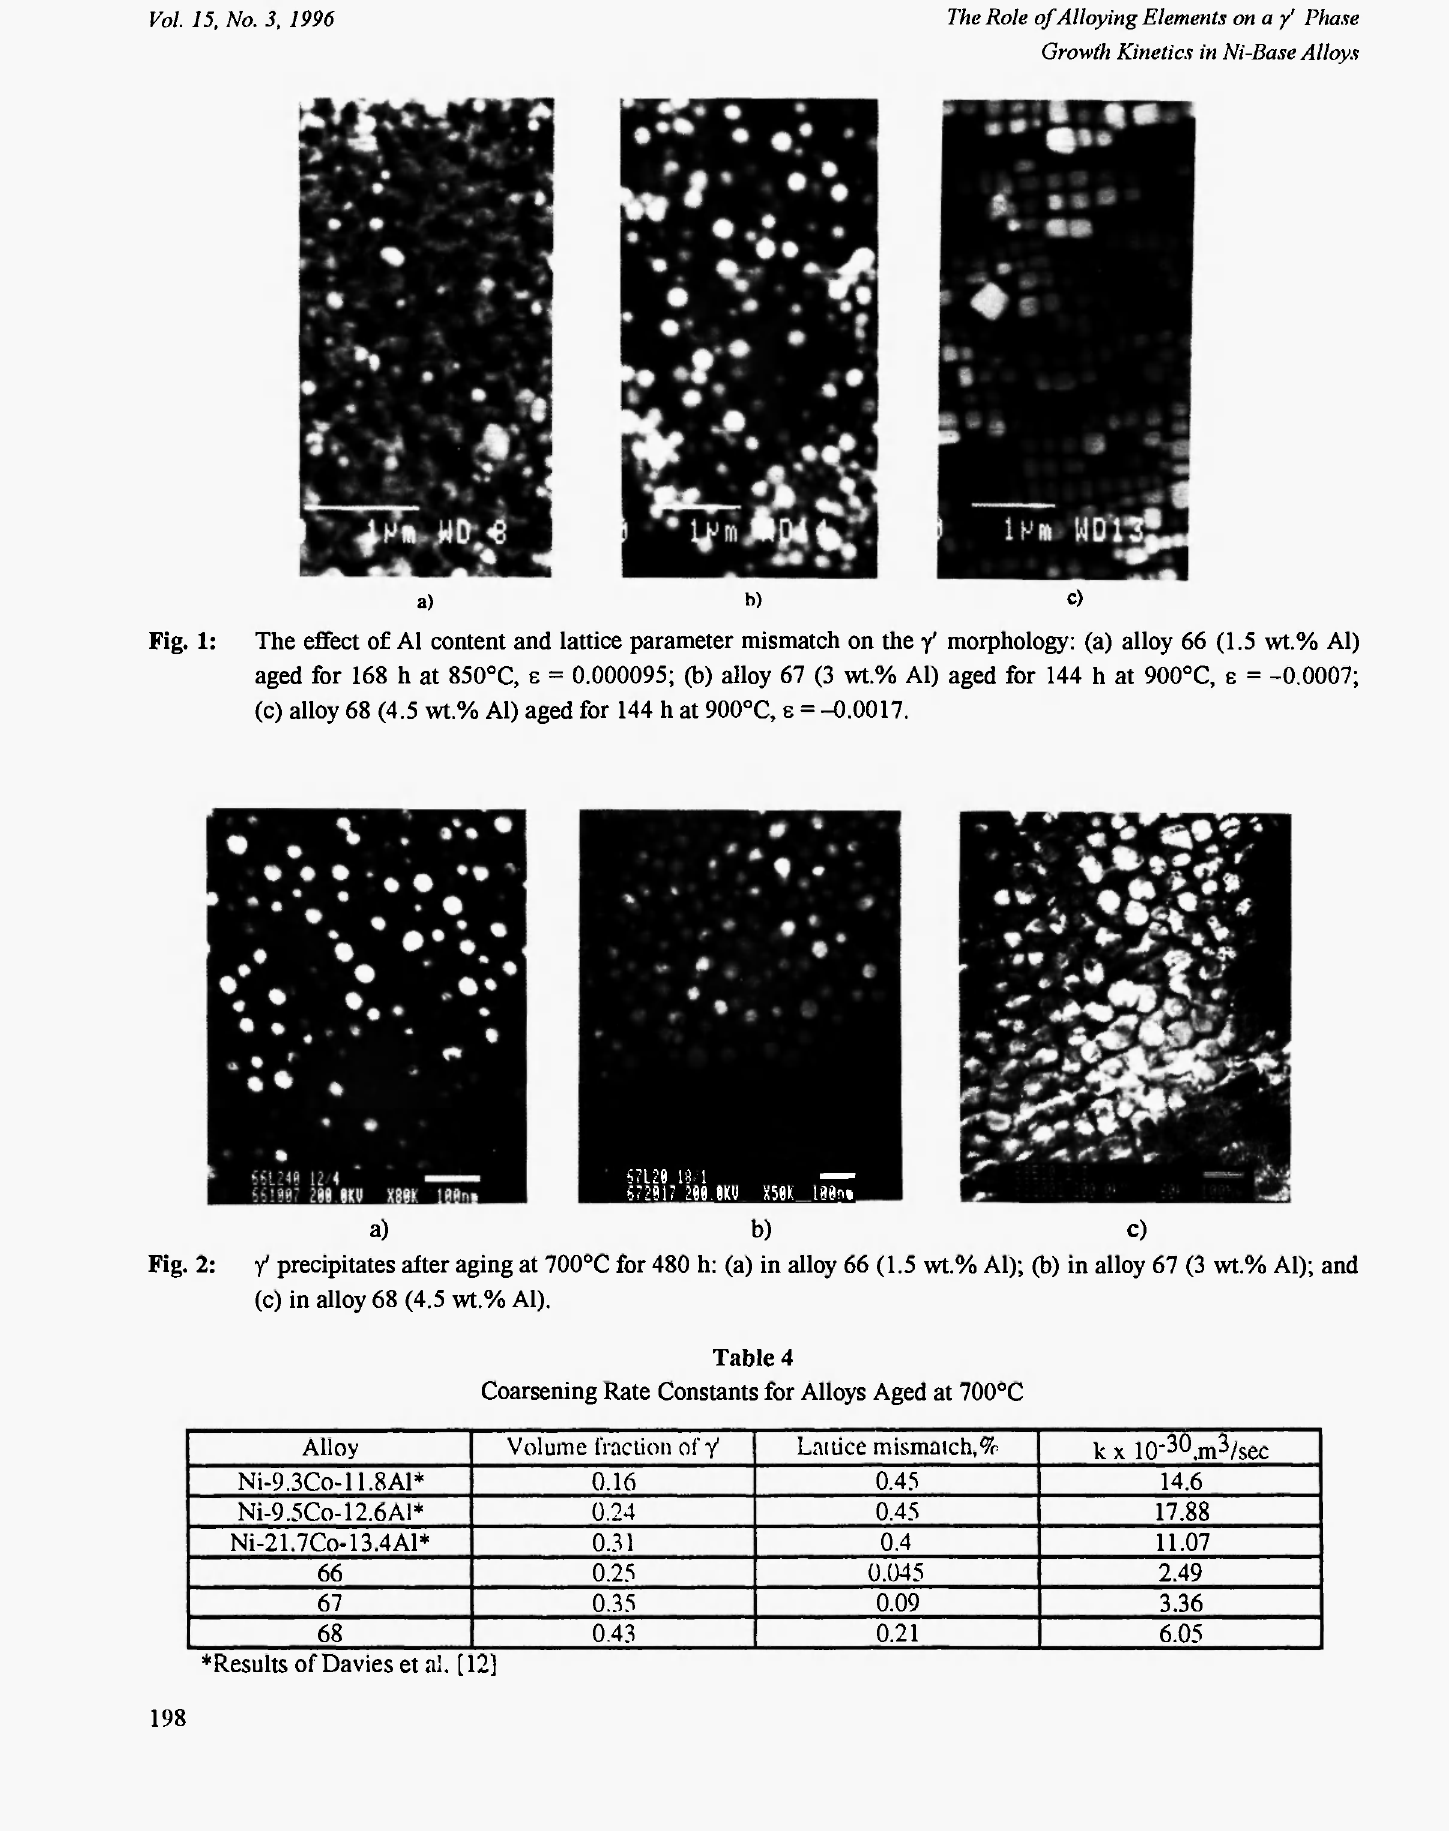
Coarsening Rate Constants for Alloys Aged at 700°C Alloy Volume fraction of